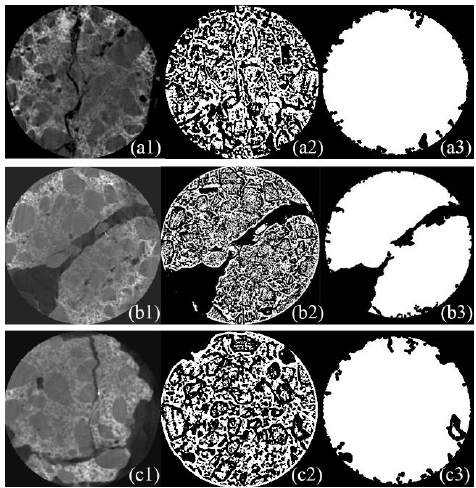
Figure 10. Initial microCT images for mortar-reference ( a 1 ), mortar-SAPs-1 ( b 1 ) and mortar-SAPs-2 ( c 1 ), resulting images for mortar-reference ( a 2 ), mortar-SAPs-1 ( b 2 ) and mortar-SAPs-2 ( c 2 ) and ROI images for mortar-reference ( a 3 ), mortar-SAPs-1 ( b 3 ) and mortar-SAPs-2 ( c 3 ) after adaptive thresholding method and shrink-wrap function are applied before healing treatment.